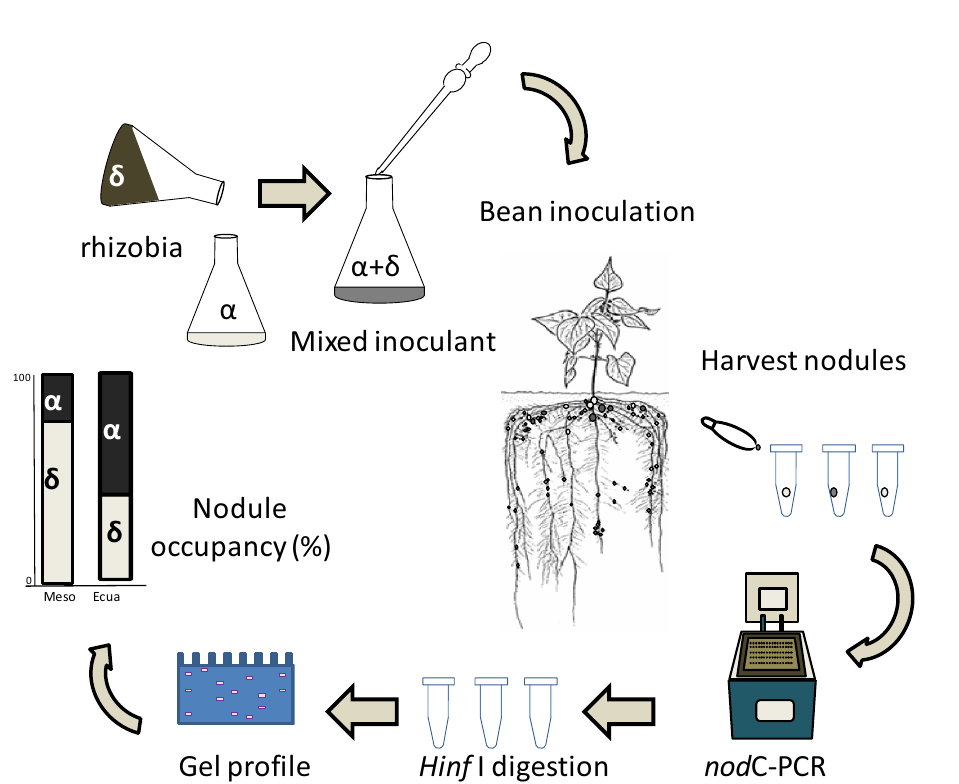
Figure 1. Experimental design to perform competitiveness analysis of nodule occupancy in common beans inoculated with a mixture of sympatric and allopatric rhizobia. Nodules were harvested three weeks after